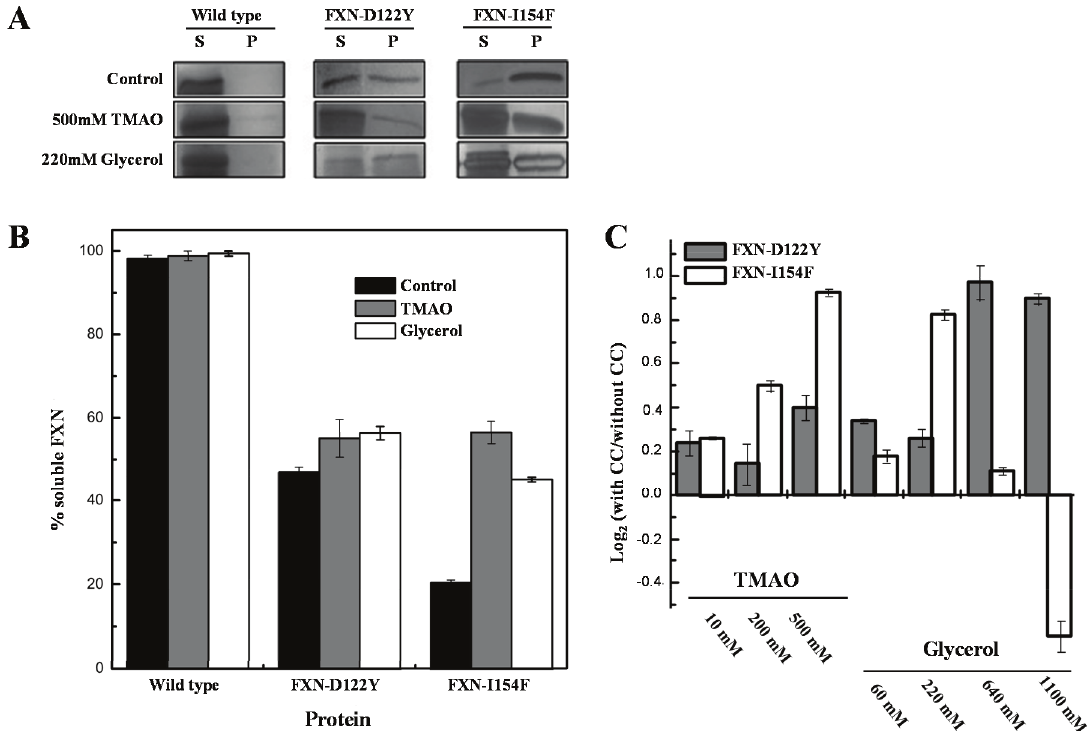
Figure 5. Effect of chemical chaperones on early folding events. ( A ) SDS/PAGE gels obtained from E. coli lysates expressing frataxin. For each protein variant, the soluble (S) and insoluble (P) fractions are shown; ( B ) Semi-quantitative analysis of the relative proportion of frataxin present in the soluble and insoluble fractions, obtained from densitometric analysis of gel bands ( n = 3), allowed the determination of the protein expressed in the soluble form; ( C ) Variation of the folding efficiency induced by the presence of chemical chaperones (increasing concentrations of TMAO and glycerol). After the densitometric analysis of the gel bands, the ratio between the amount of soluble protein present in the presence and absence of the compounds were determined. The Log2 of this ratio is here shown to highlight the variation